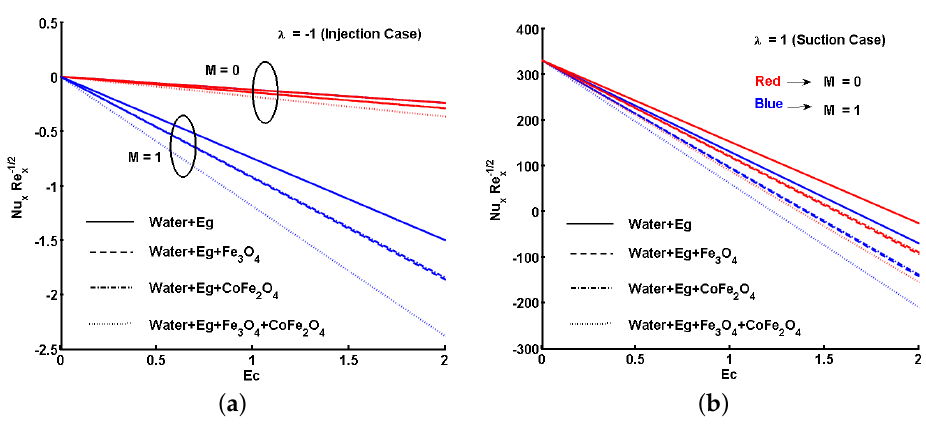
Figure 16. Effect of Eckert number ( Ec ) and magnetic parameter ( M ) on the local Nusselt number. ( a ) Injection; ( b )